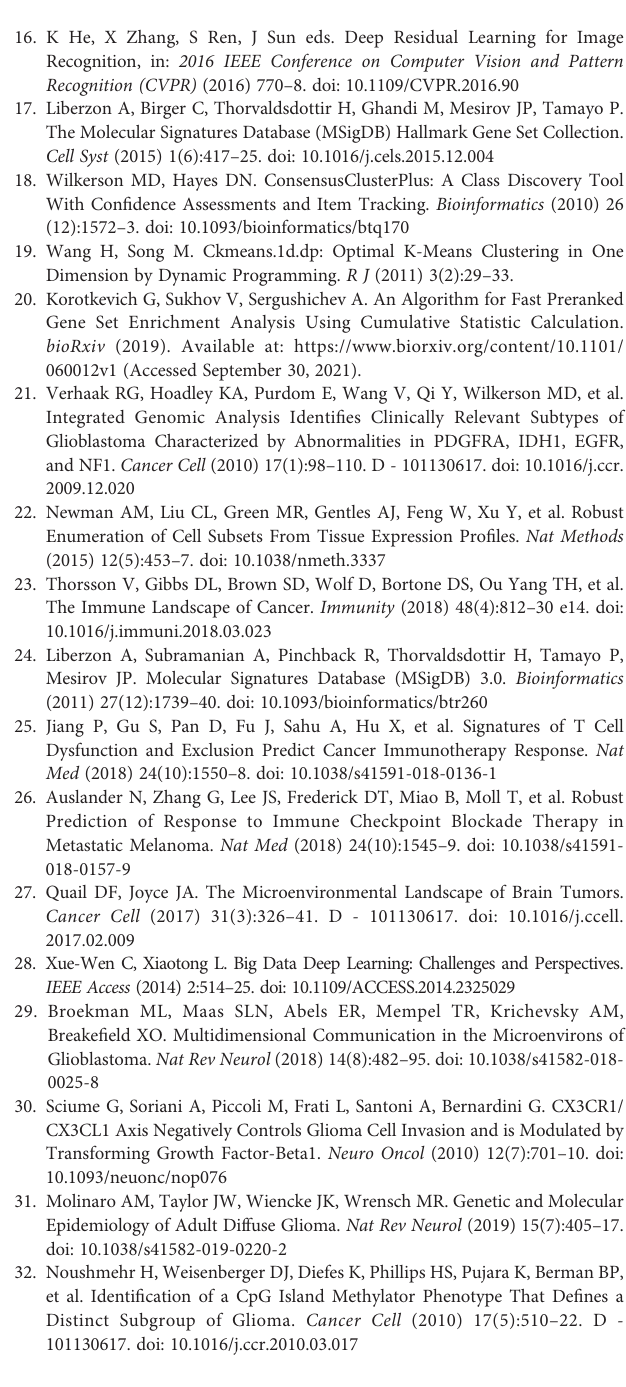
Supplementary Figure 8 | Prognostic signi fi cance of C1/2 subtypes strati fi ed by different clinical variables. (A) Kaplan-Meier survival analysis of C1 versus C2 subtype. (B) Combined forestplotportrayingmultivariate Cox regression analysisof C1/2 subtypes after controlling age, gender, histology, IDH mutation, MGMT methylation, and co-deletion of 1p and 19q. 1p/19q-, co-deletion of 1p and 19q; HR, hazard ratio; CI, con fi dence interval. Supplementary Figure 9 | Kaplan-Meier survival analysis of C1/2 subtypes classi fi ed by PCA.